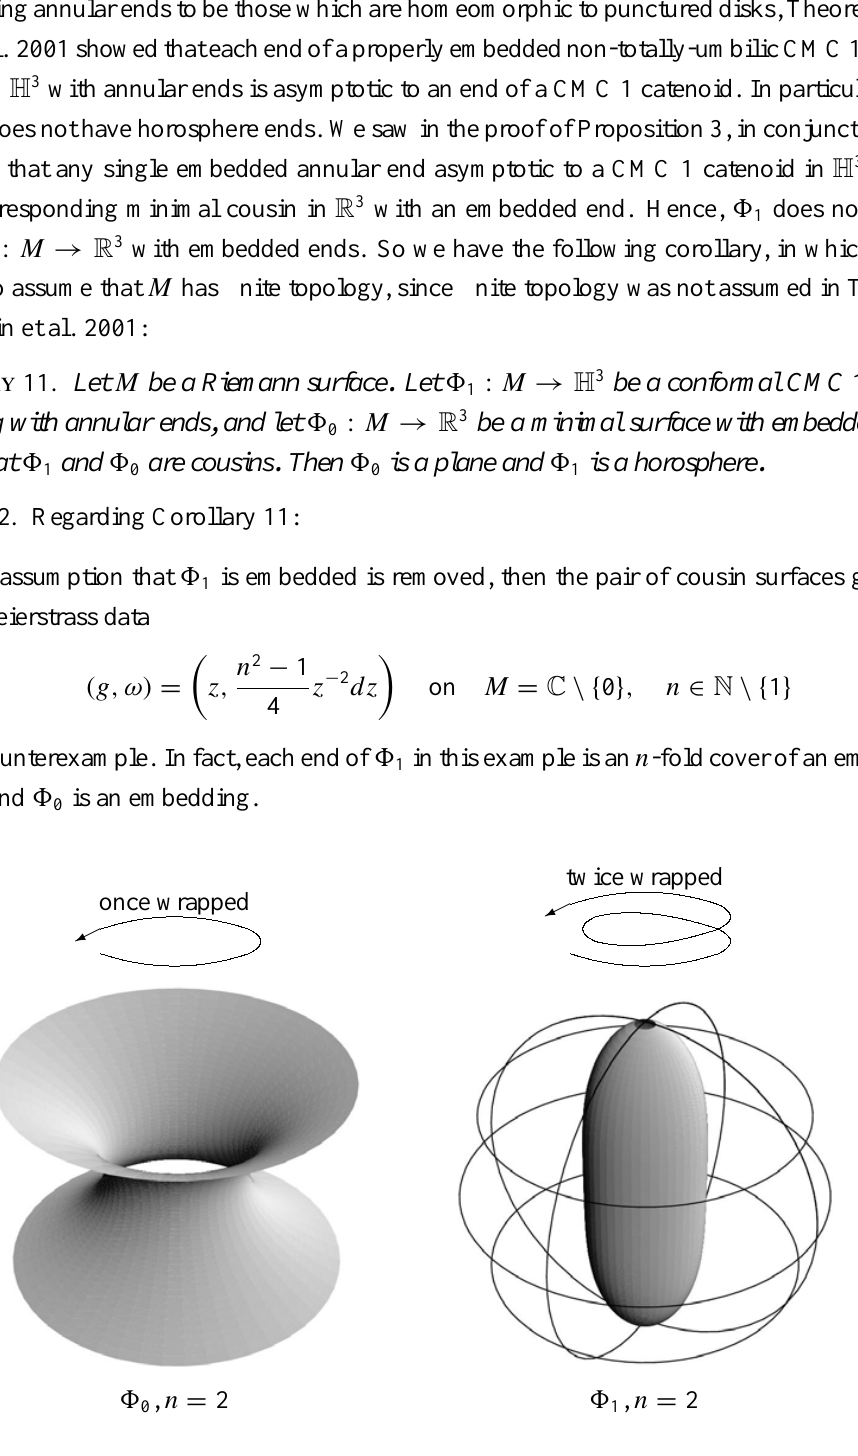
Fig. 1 – The surfaces (cid:2) 0 and (cid:2) 1 in (i) of Remark